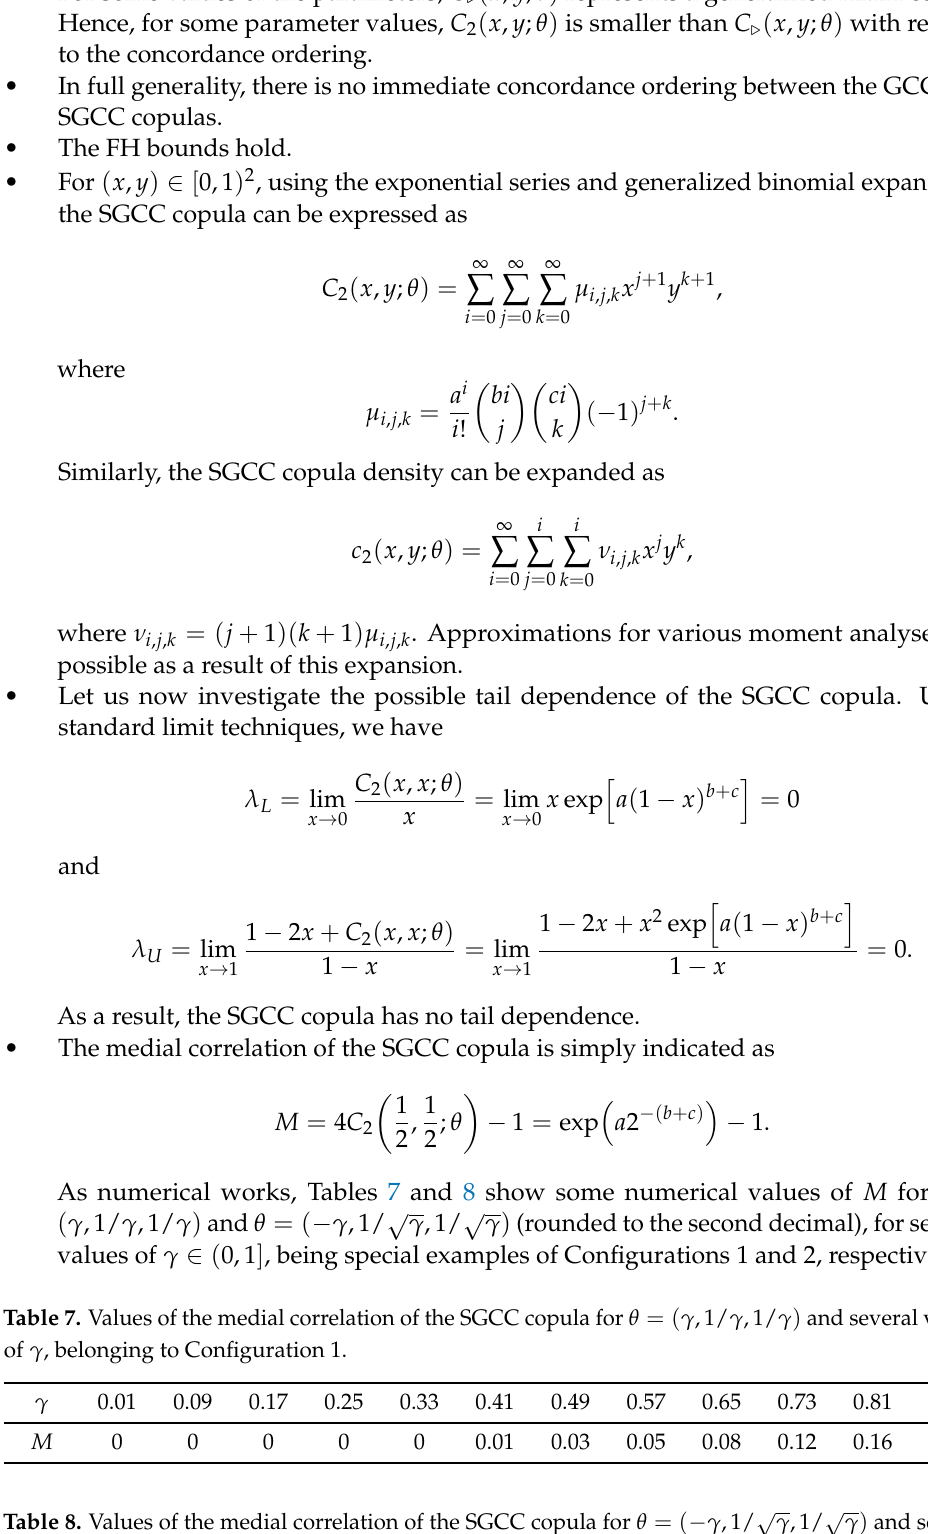
√ √ γ ,1/ γ ) and several